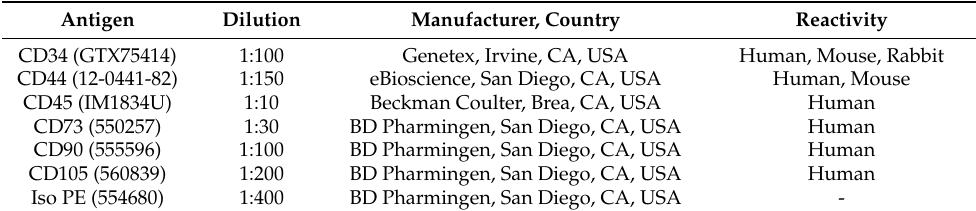
Table 1. Antibodies used in flow cytometry